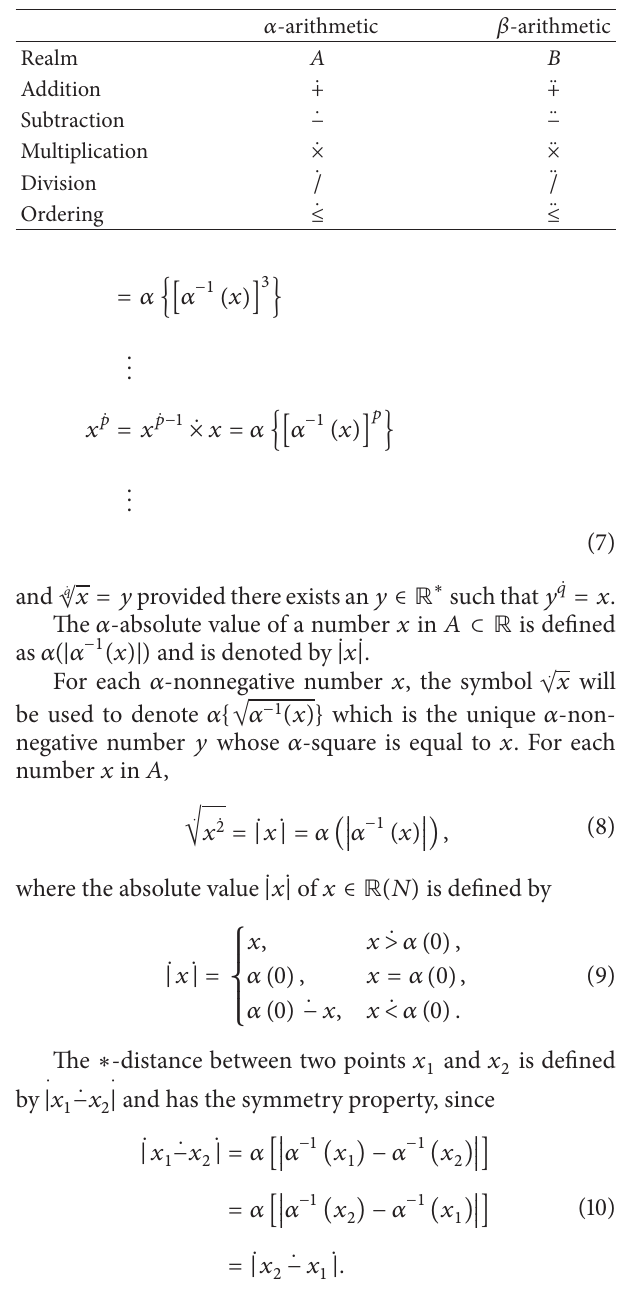
Table 1: Notation in 𝛼 -arithmetic and 𝛽